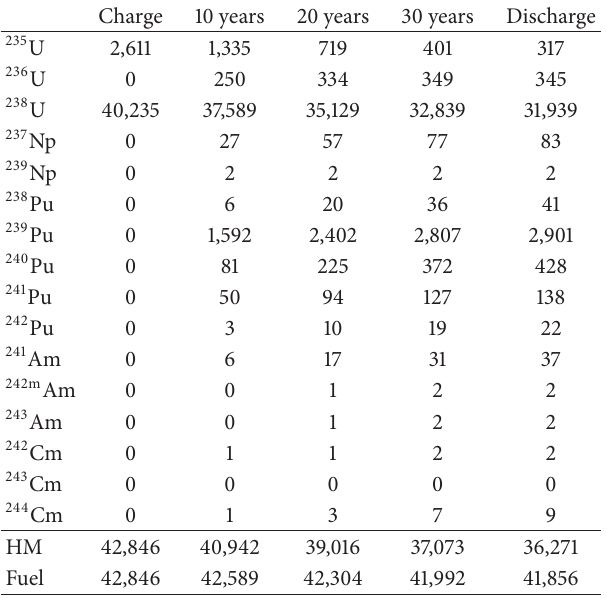
Table 2: Isotopic inventory (kg) of EM 2 baseline